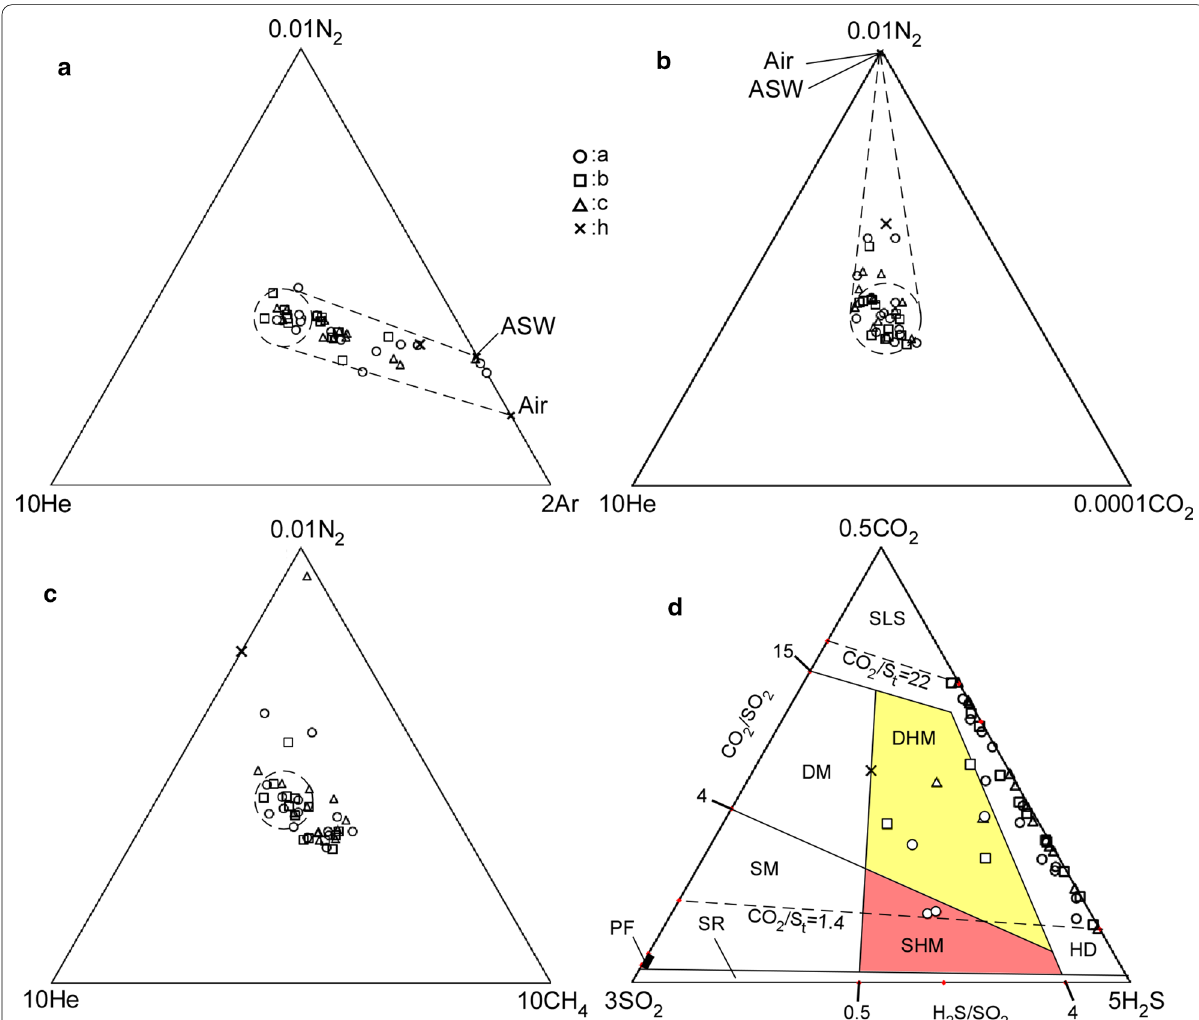
Fig. 10 a Fumarolic gas compositions in the He–N 2 –Ar ternary system; broken circle indicates the expected magmatic end member. ASW is the composition of air dissolved in water. Broken lines indicate the mixing between the magmatic and atmospheric end members. b Fumarolic gas compositions in the He–N 2 –CO 2 ternary system; broken circle indicates the expected magmatic end member. Broken lines indicate the mixing between the magmatic and atmospheric end members. c Fumarolic gas composition in the He–N 2 –CH 4 ternary system; broken circle indicates the expected magmatic end member. d Fumarolic gas composition in the SO 2 –CO 2 –H 2 S ternary system classified as a hydrothermal system (Stix and de Moor 2018). SLS, HD, DHM, SHM, DM, SM and SR indicate the types of volcanic gas with the following geneses: “S loss scrubbing”, “hydrothermally dominated”, “deep hydrothermal-magmatic”, “shallow hydrothermal-magmatic”, “deep magmatic”, “shallow magmatic” and “sulfur remobilization”, respectively. PF indicates the estimated parental magmatic fluid in the Kirishima volcanic area (Ohba et al. 1997). The CO 2 /SO 2 and H 2 S/SO 2 molar ratios are calibrated on the left and bottom sides, respectively. The CO 2 /St isomolar ratio is indicated by broken lines where St is the summation of